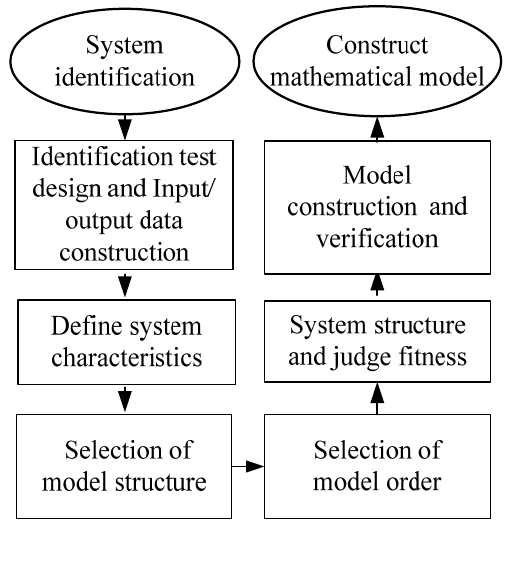
Figure 5. System identification flow chart.